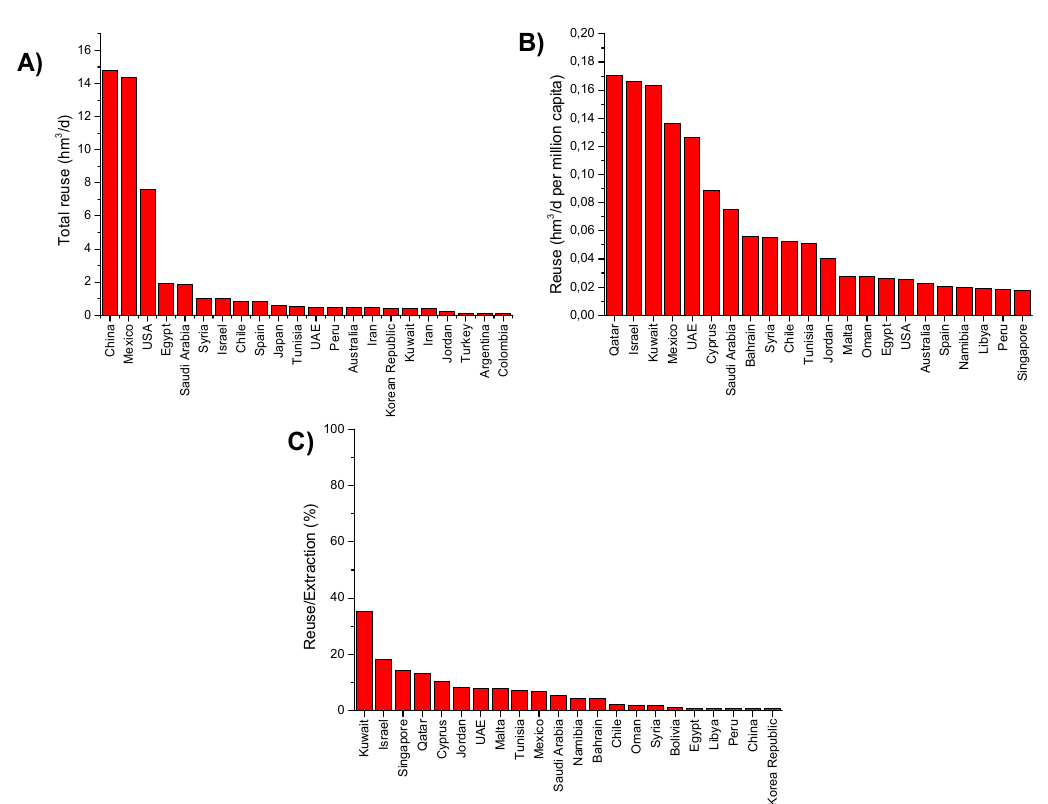
Figure 1. Global situation of wastewater reuse around the world. Adaptation from [45]. ( A ) Total reuse of wastewater (hm 3 /d); ( B ) reuse (hm 3 /d per million capita); ( C ) percentage of reuse/extraction.